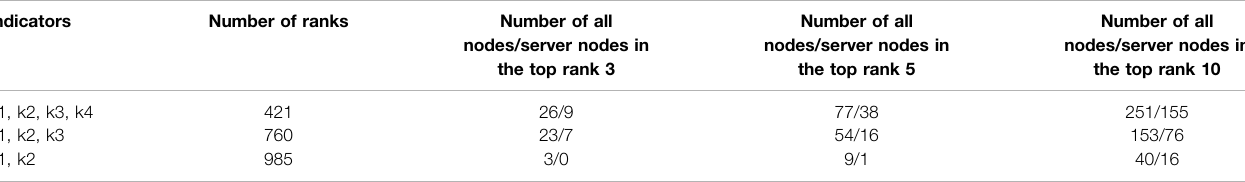
TABLE 5 | The partial order results of three sort combinations in